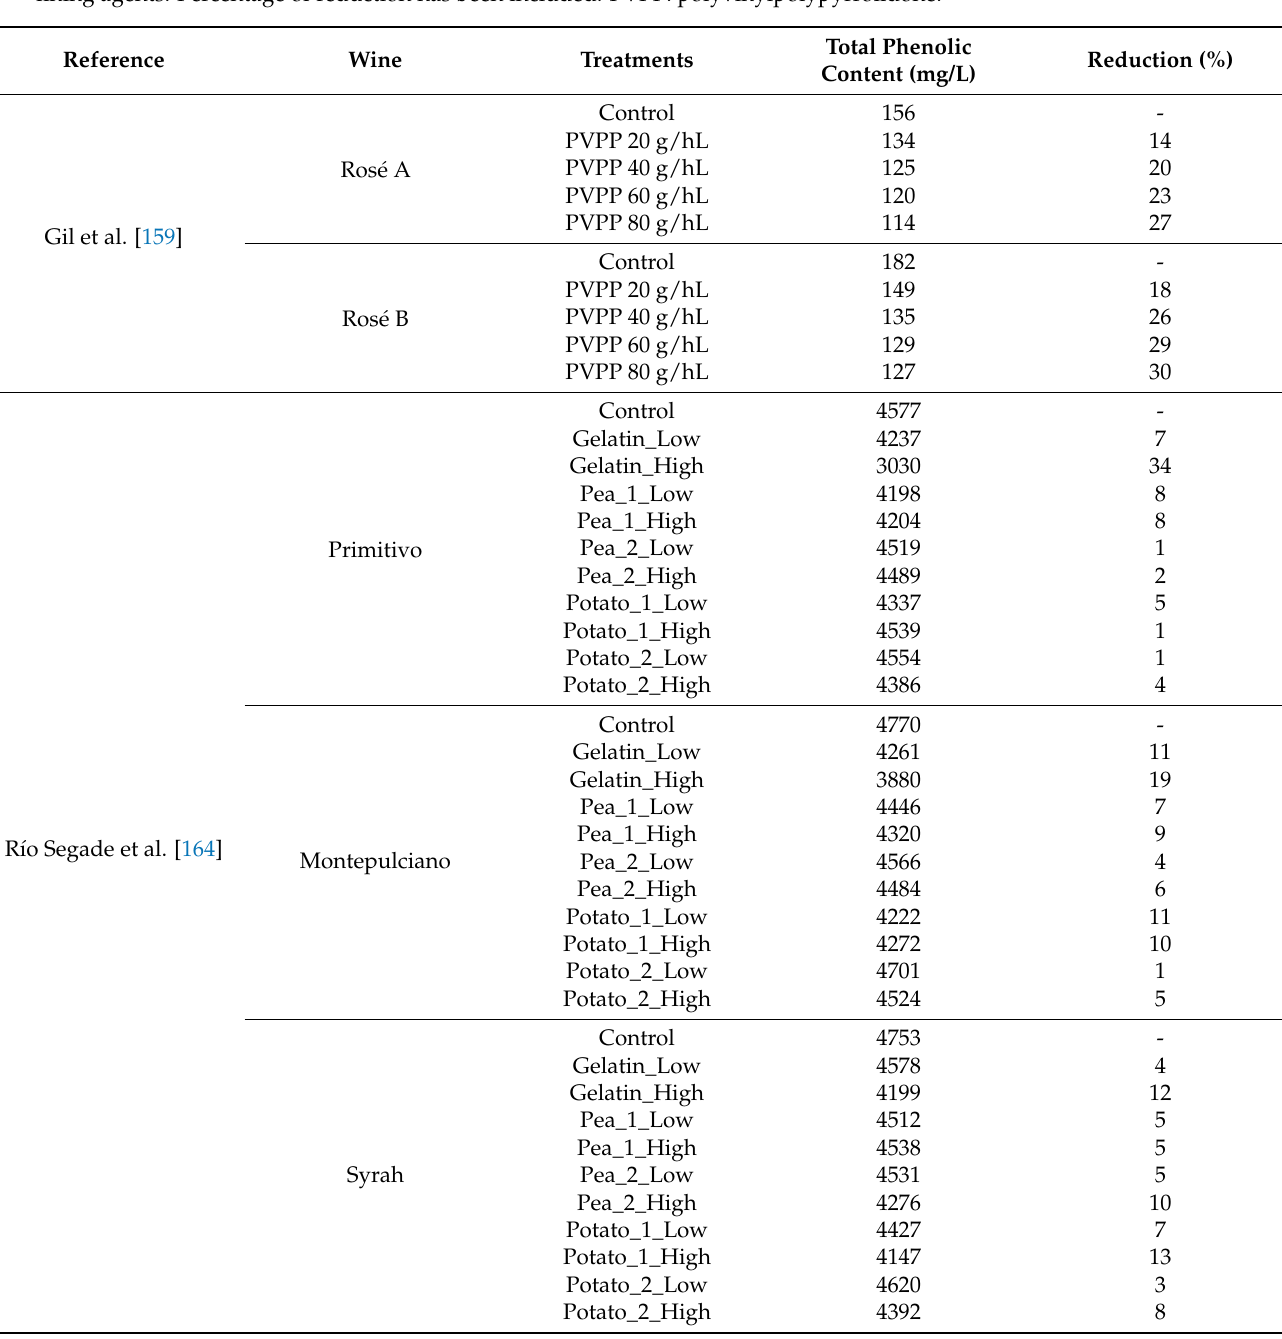
Table 3. Total phenolic concentration (mg/L) in wines from different varieties treated with chemical, animal and plant fining agents. Percentage of reduction has been included. PVPP: polyvinylpolypyrrolidone. Reference Wine Treatments